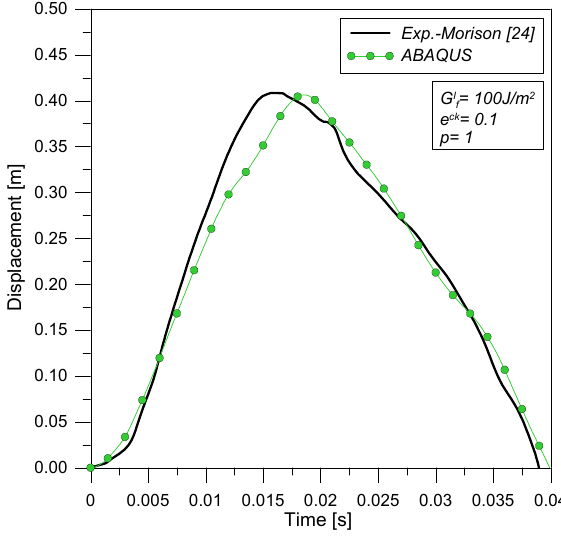
Figure 10. Deflection at the center of panel. Experimental (Morison, [24]) and numerical (ABAQUS)